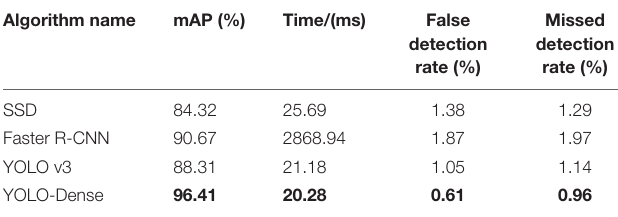
TABLE 3 | Comparison of detection accuracy (AP) (%). TABLE 4 | Comprehensive performance